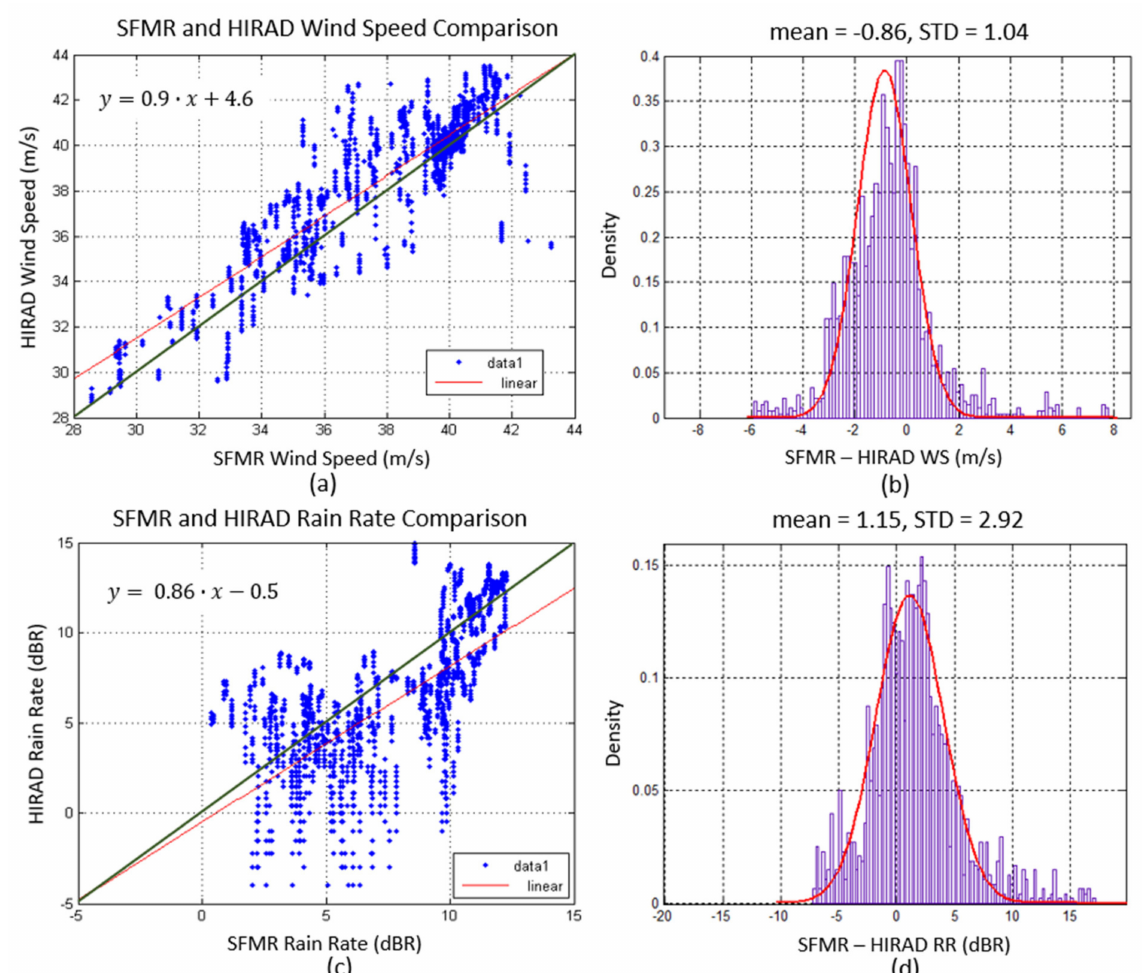
Figure 16. HIRAD to SFMR WS and RR retrieval comparisons, where ( a , b ) are the wind speed scatter diagram and the histogram of the difference between SFMR-HIRAD, and ( c , d ) are the comparisons of rains rates. The green line in the scatter diagrams represents one-to-one fit, while the red line is the linear